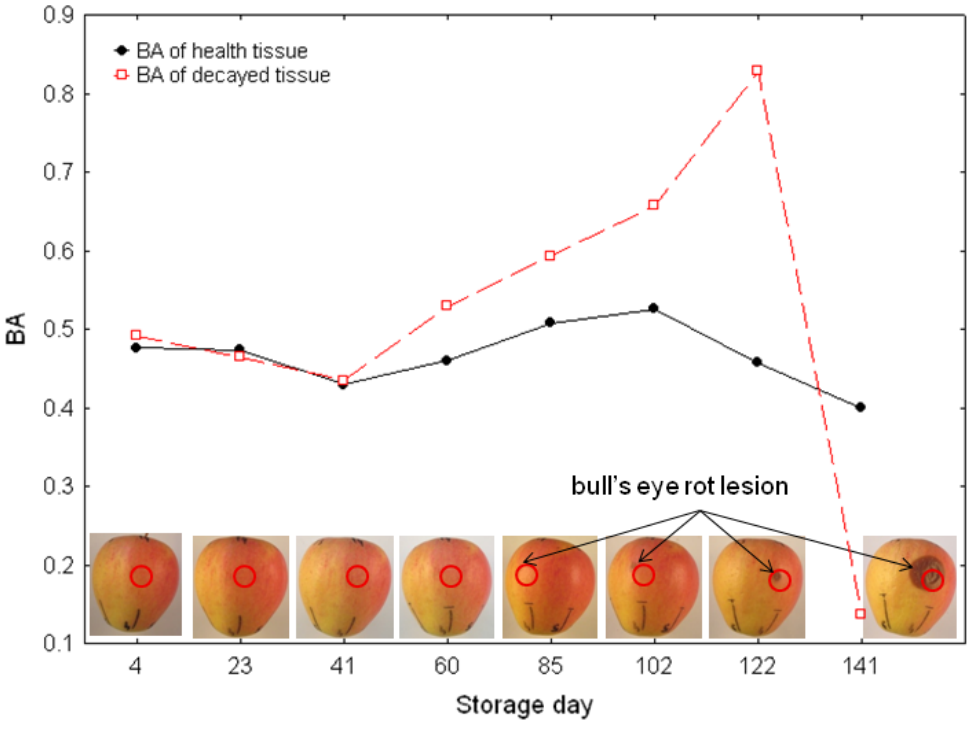
Figure 4. Biospeckle activity BA of one selected ‘Pinova’ apples for healthy and decaying tissue during storage. Photographic documentation of apple bull’s eye rot development is also given. Lesion area is marked by black arrow and red circle presents laser illumination